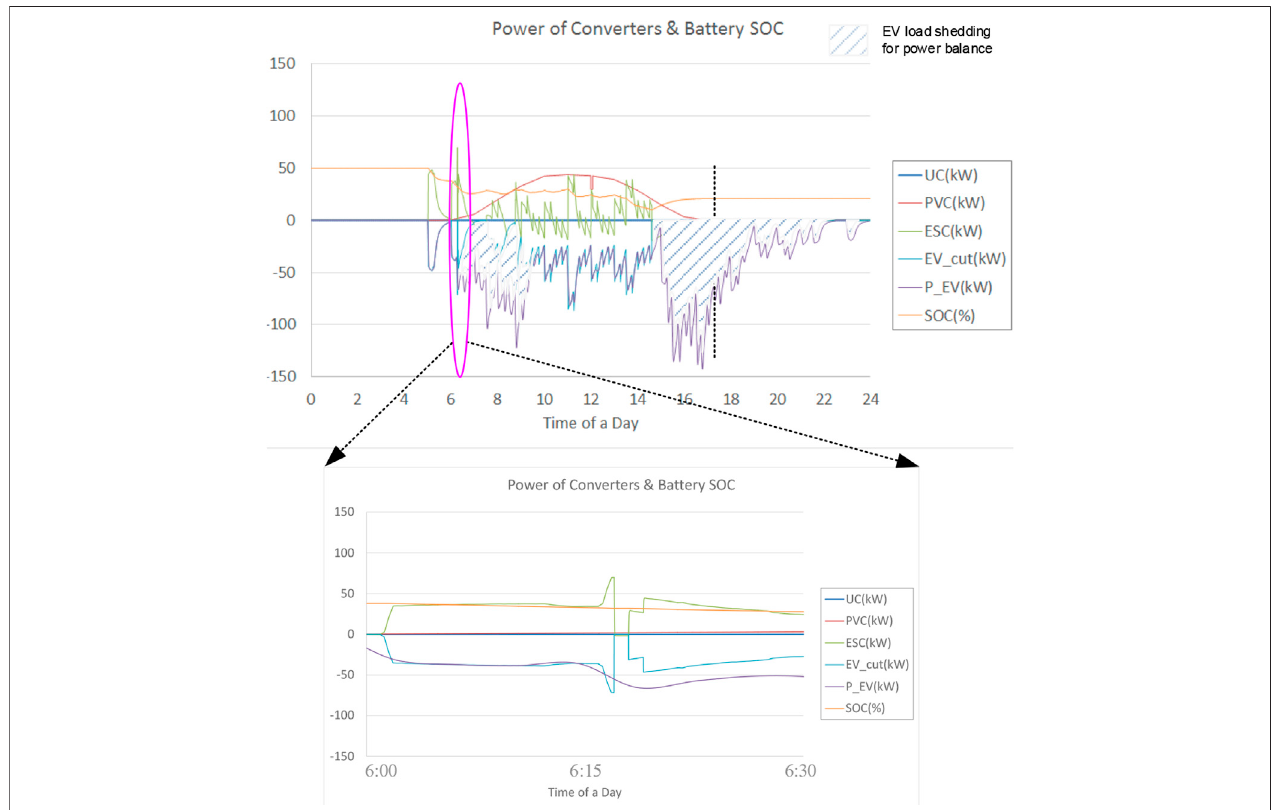
FIGURE 6 | Power distribution of each converter in a 24-h simulation of the third functionality (FUN.3).